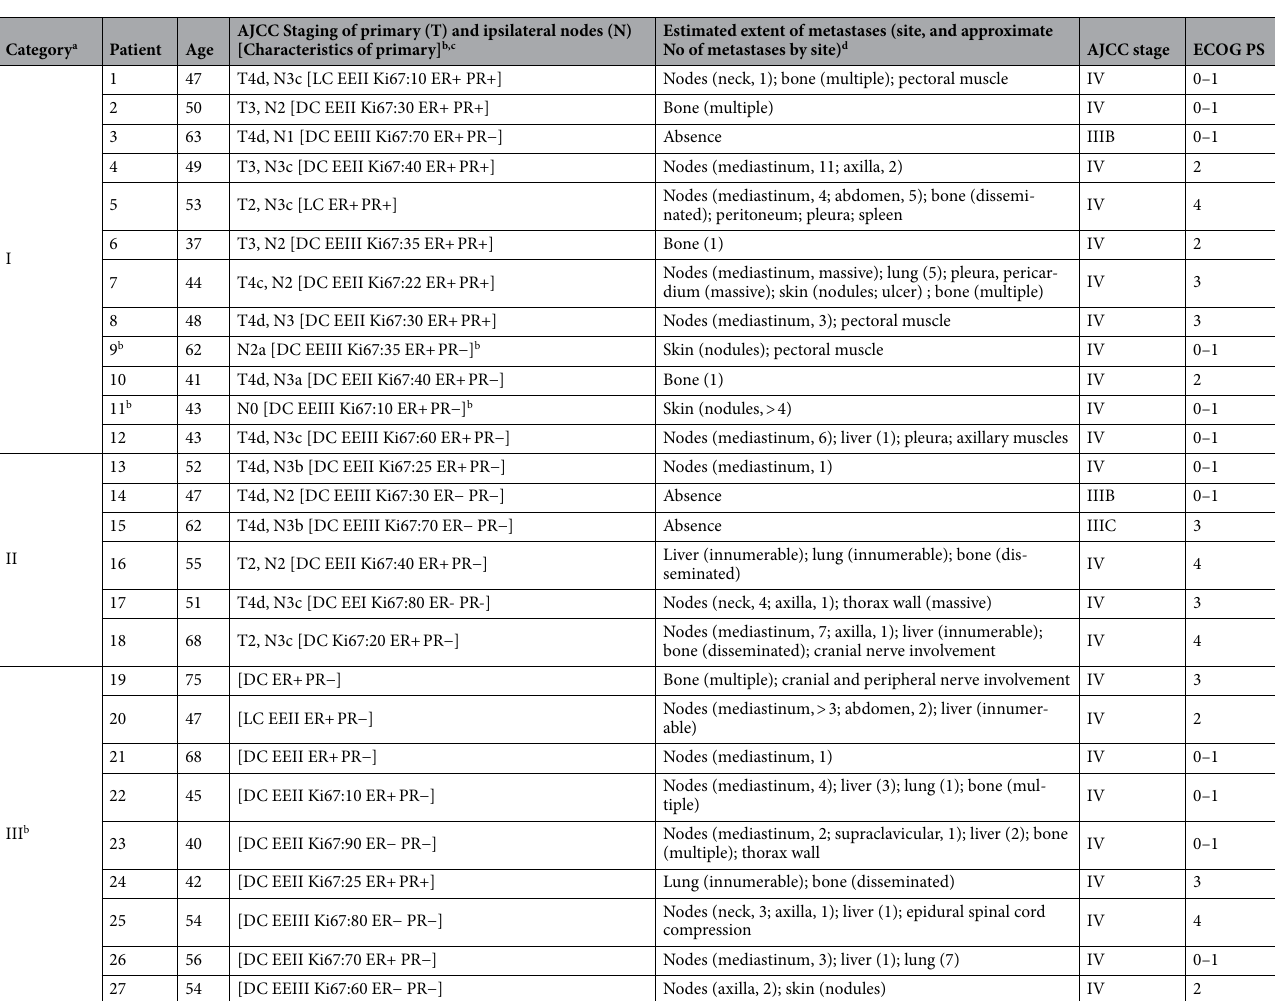
Table 1. Characteristics of patients with advanced breast carcinoma treated with regimens including 5-fluorouracil, folinic acid, and pyridoxine in tandem. a Categories of patients are I, previously untreated patients whose tumors did not overexpress HER2 (1–12); II, previously untreated patients whose tumors overexpressed (3+) HER2 (13–18); and III, patients who had received prior chemotherapy whose tumors did not overexpress HER2 (19–27). b Patient with prior mastectomy. c LC lobular carcinoma, DC ductal carcinoma, EE Elston-Ellis pathologic grade, Ki67 expression in percent of cancer cells, ER estrogen receptors, PR progesterone receptors. d Axilla refers to metastatic lymph nodes in axilla contralateral to